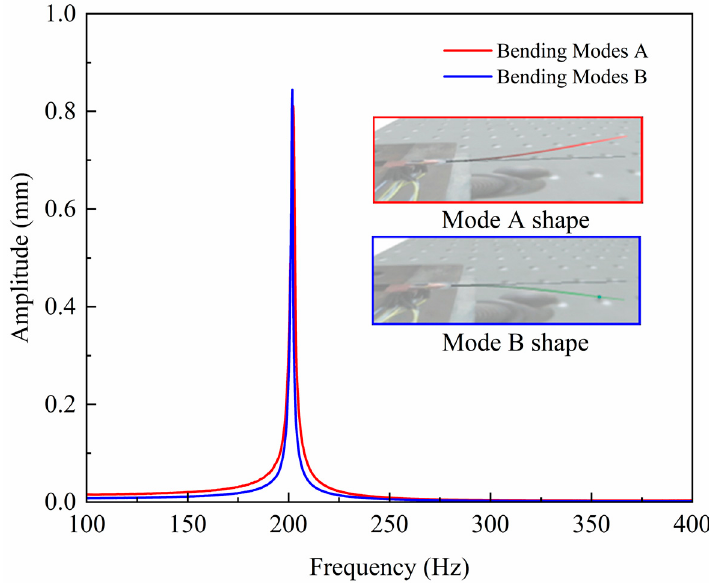
Figure 13. 3D vibration measurement results.